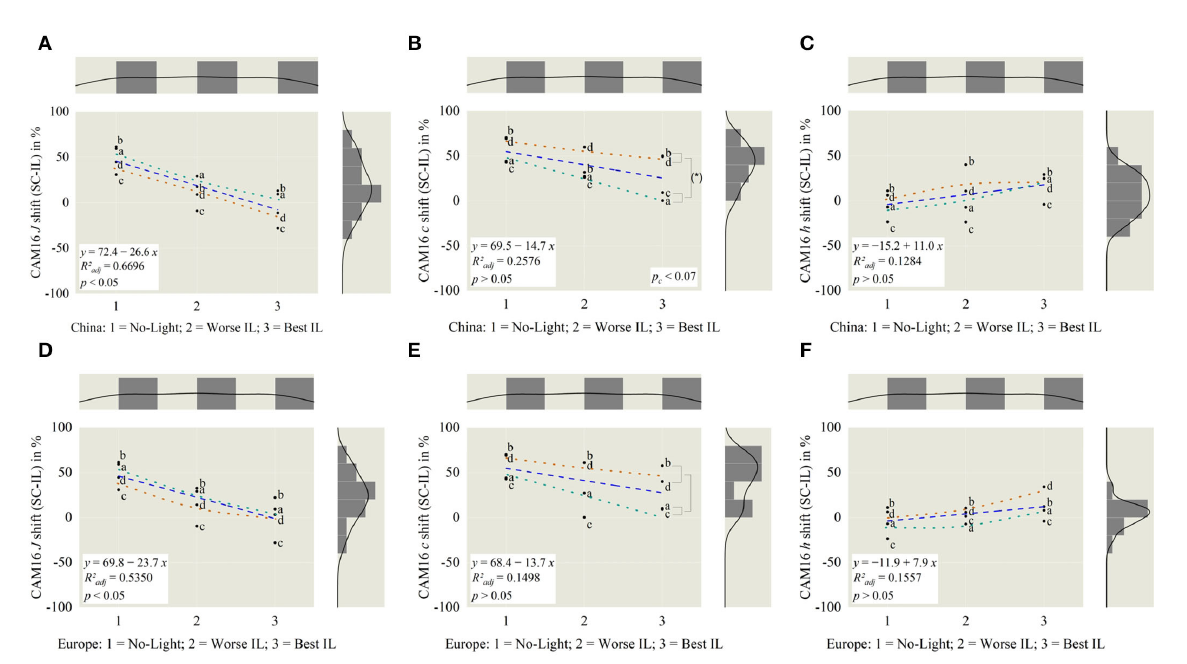
FIGURE10 Based on China in CAM16, for (A) lightness J = − 31.8, slope is significantly different from zero. For (B) chroma c and (C) hue h , the slopes are not different. Tendency lines like Figure 9. Chroma significantly varied ( p c < 0.07) between brighter and darker external scenery a and d (B) . For reference (D–F) , CAM dimensions from Europe